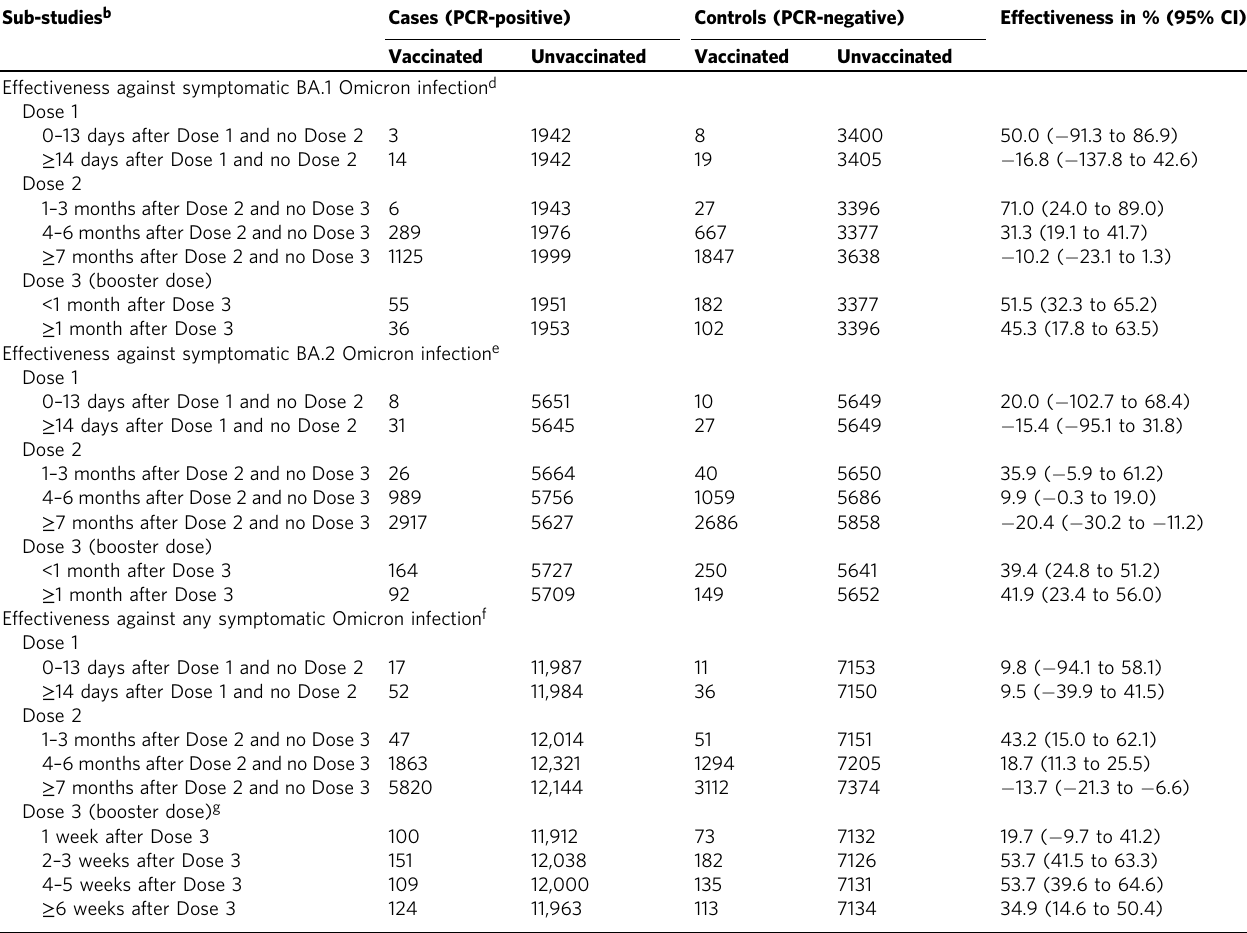
Table 4 Effectiveness of the mRNA-1273 vaccine against symptomatic SARS-CoV-2 BA.1 Omicron infection, BA.2 Omicron infection, and any Omicron infection a